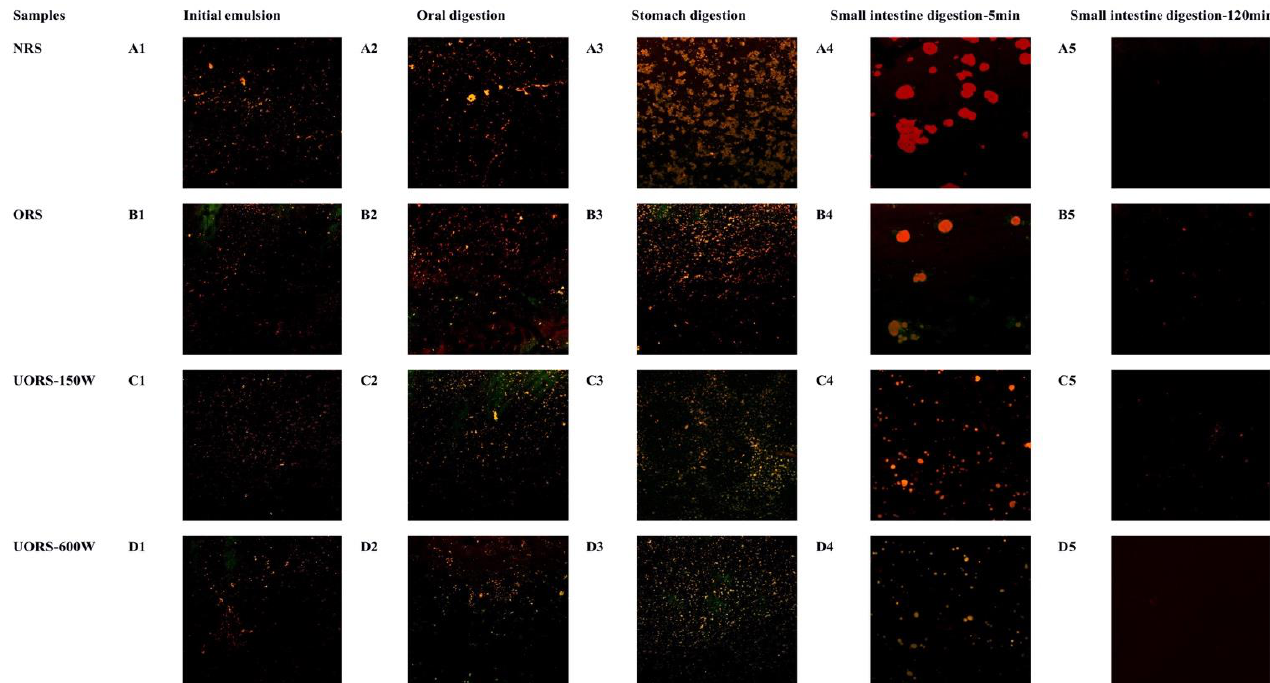
Figure 2. Changes in the microstructure of curcumin emulsions stabilized by native rice starch or OSA starch during in vitro digestion .